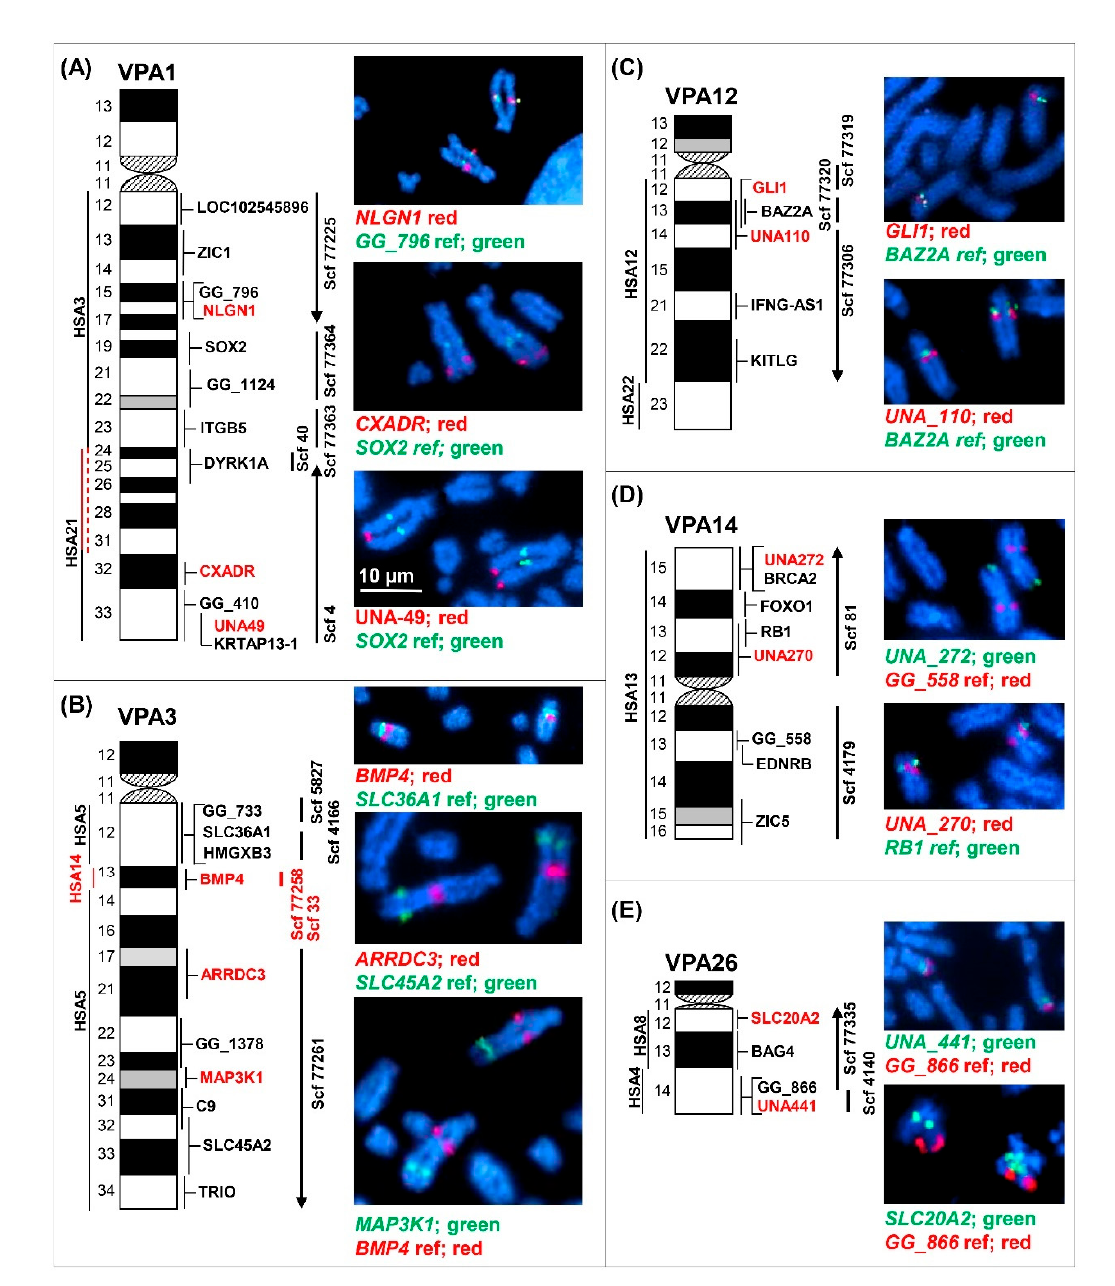
Figure 1. Selected examples of fluorescence in situ hybridization (FISH) mapping in five alpaca chromosomes: ( A ) VPA1; ( B ) VPA3; ( C ) VPA12; ( D ) VPA14, and ( E ) VPA26. Chromosome ideograms with cytogenetic nomenclature, conserved synteny with human and all cytogenetically mapped markers (new markers in red font) are shown on the left; vertical lines in the middle show corresponding VicPac3.1 sca ff olds; lines with arrowheads indicate orientation, and microscope images with FISH results are on the